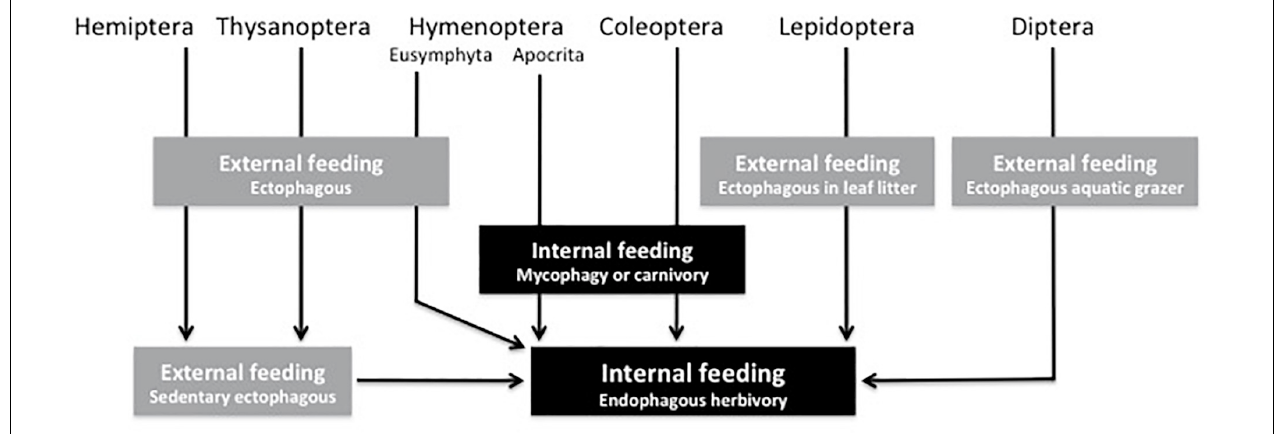
FIGURE 1 | The ancestral feeding modes of six herbivorous insect orders and how they led to endophagy.